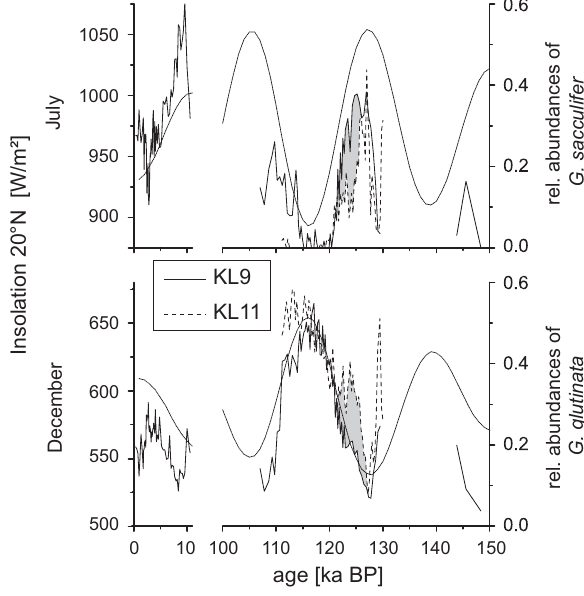
Fig. 8. Comparison of species abundances with insolation data (20 ◦ N). Left: Holocene data only for KL9 (Trommer et al., 2010), right: this study including KL9 and KL11, above: July insolation and G. sacculifer abundances, below: December insolation and G. glutinata abundances. Grey shading indicates faunal offset during termination II, when KL11 was influenced by intruding intermedi- ate waters during pronounced summer